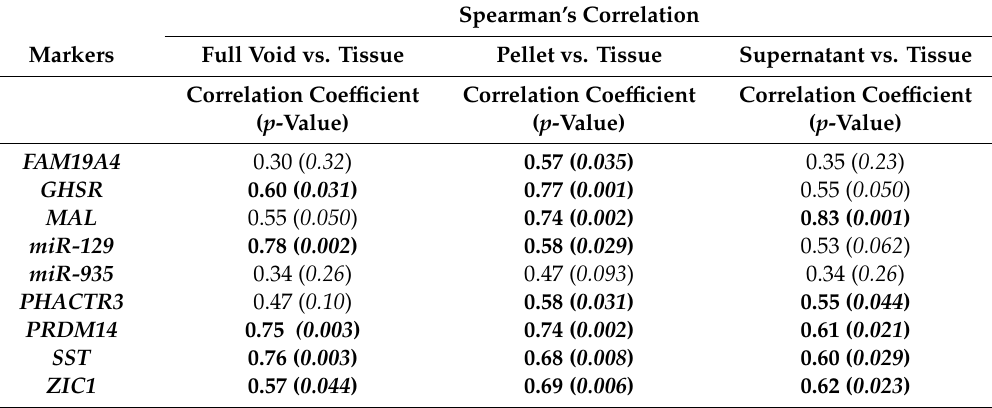
Table 2. Correlation between the methylation levels in the urine fractions and matched tumor tissues of the bladder cancer patients ( n = 14). Spearman’s correlation was used to calculate the correlation coe ffi cients and corresponding p